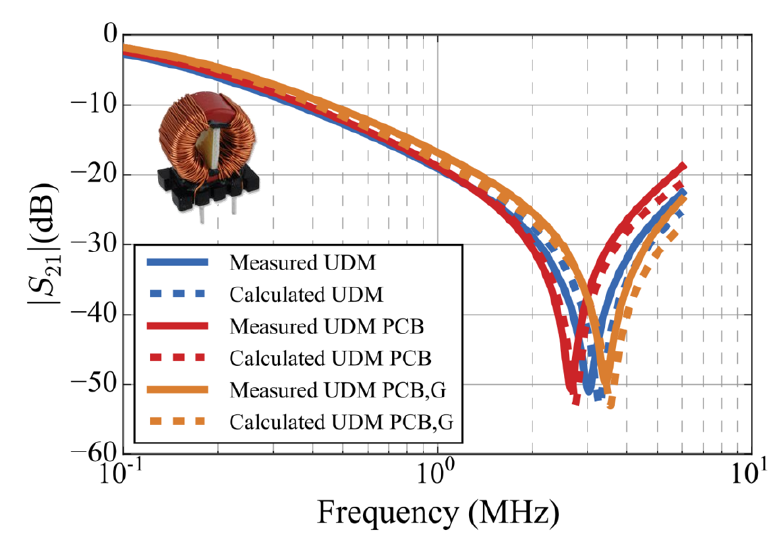
Figure 10. A 2.2mH CMC, listed in Table 2 as WÜRTH ELEKTRONIK 744824622, mounted on a | of the capacitive coupling of the signal traces to the PCB fabricated to check the impact on | S UDM 21 return plane.